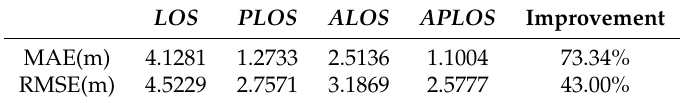
Figure 12. Zig-zag path following under constant ocean currents ( u = 1.5 m/s). ( a ) comparison of trajectory; ( b ) comparison of cross-track error; ( c ) comparison of look-ahead distance; ( d ) comparison of velocity and drift angle; ( e ) comparison of heading effect. Table 3. Performance metric of zig-zag tracking under constant ocean currents ( u = 1.5